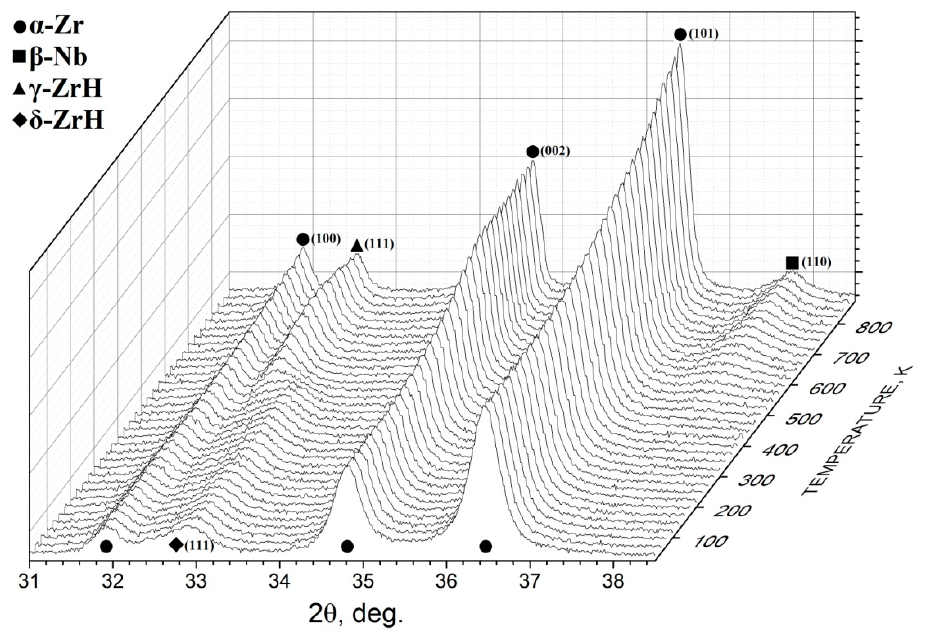
Figure 5. Parts of the diffraction pattern of the UFG Zr–1Nb–0.33H alloy upon heating to 1173 K.